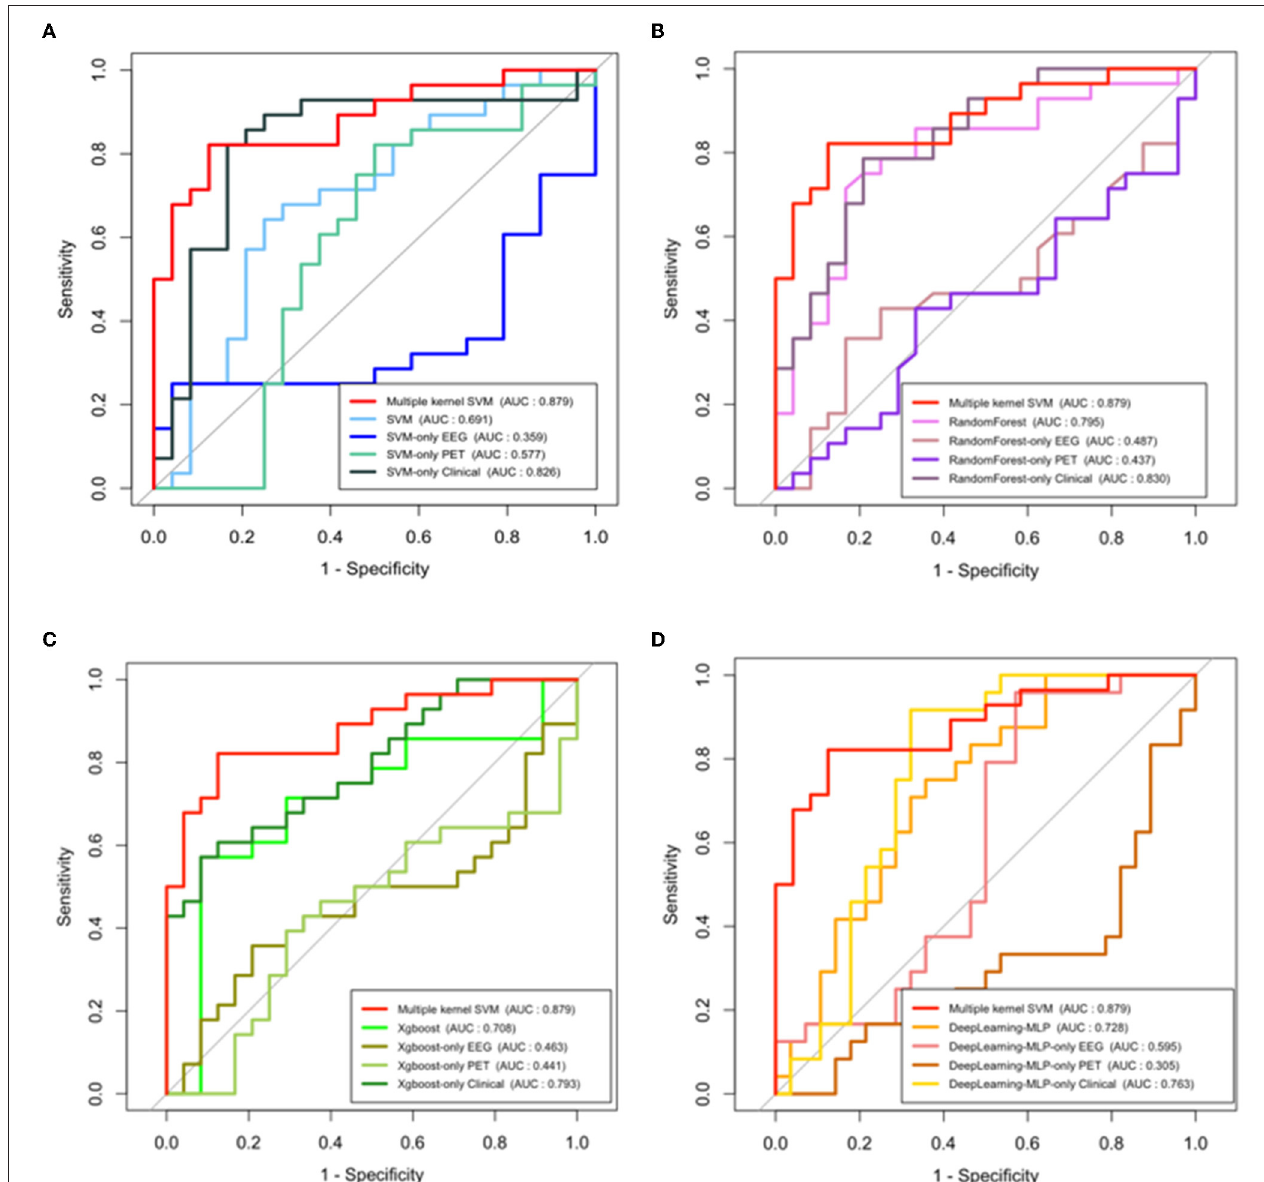
FIGURE 5 | ROC curves and AUC values of single modal models and multiple-kernel SVM with each conventional machine learning methods. (A) SVM, (B) random forest, (C) Xgboost, and (D) deep learning (multilayer perceptron model).